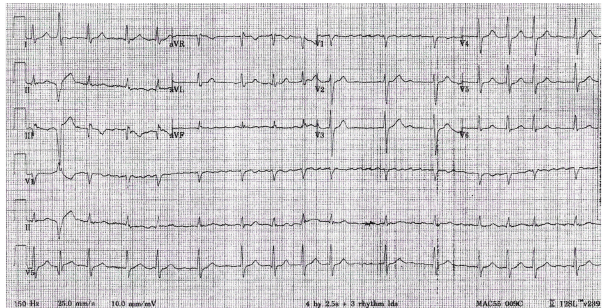
Figure 1: Electrocardiogram shows irregular rhythm consistent with atrial fibrillation with a ventricular rate of 97, no ST segment, or T wave changes suggestive of